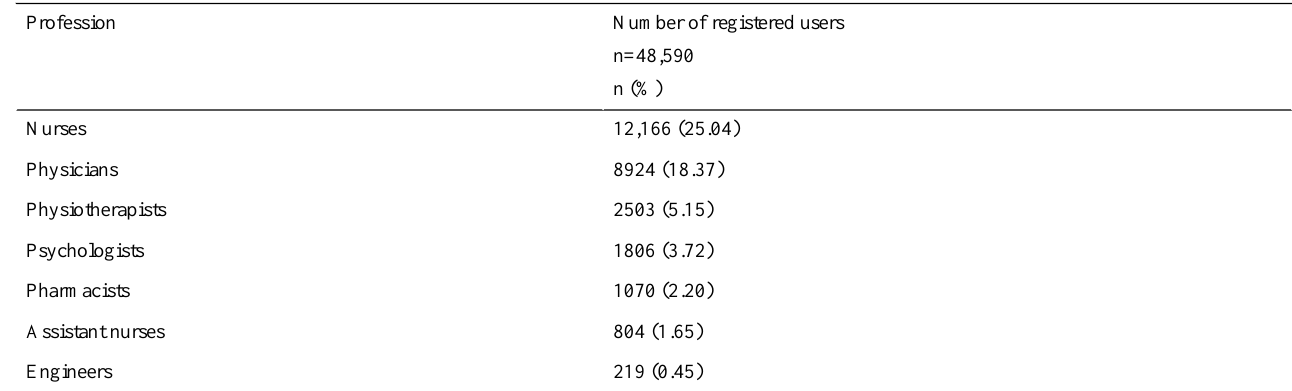
Table 2. Profession and number of registered personal users of The Library